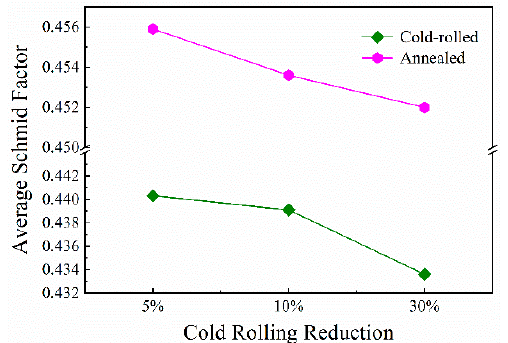
Figure 10. Average Schmid factor as a function of cold-rolling reduction for cold-rolled and annealed samples.